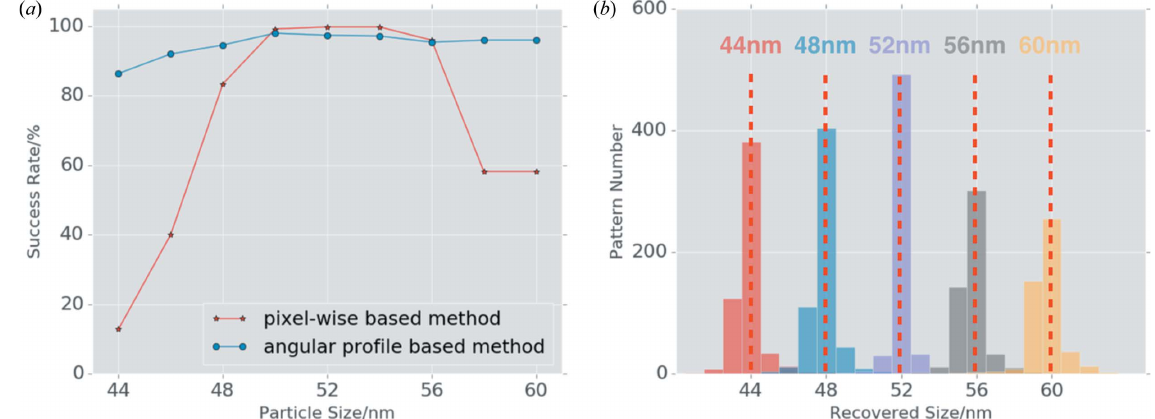
Figure 3 Orientation recovery and size analysis for simulated data. ( a ) Orientation recovery results with the pixel-level method and the angular profile method. The angular profile method (blue curve) is more robust in the presence of size variation than the pixel-level method (red curve). ( b ) Size determination for the simulated data. The red dashed lines indicate the actual values of particle size, while the histograms show the size distribution obtained using our method. The particle sizes are narrowly distributed, and the differences between the mean values of each group and the actual values are within